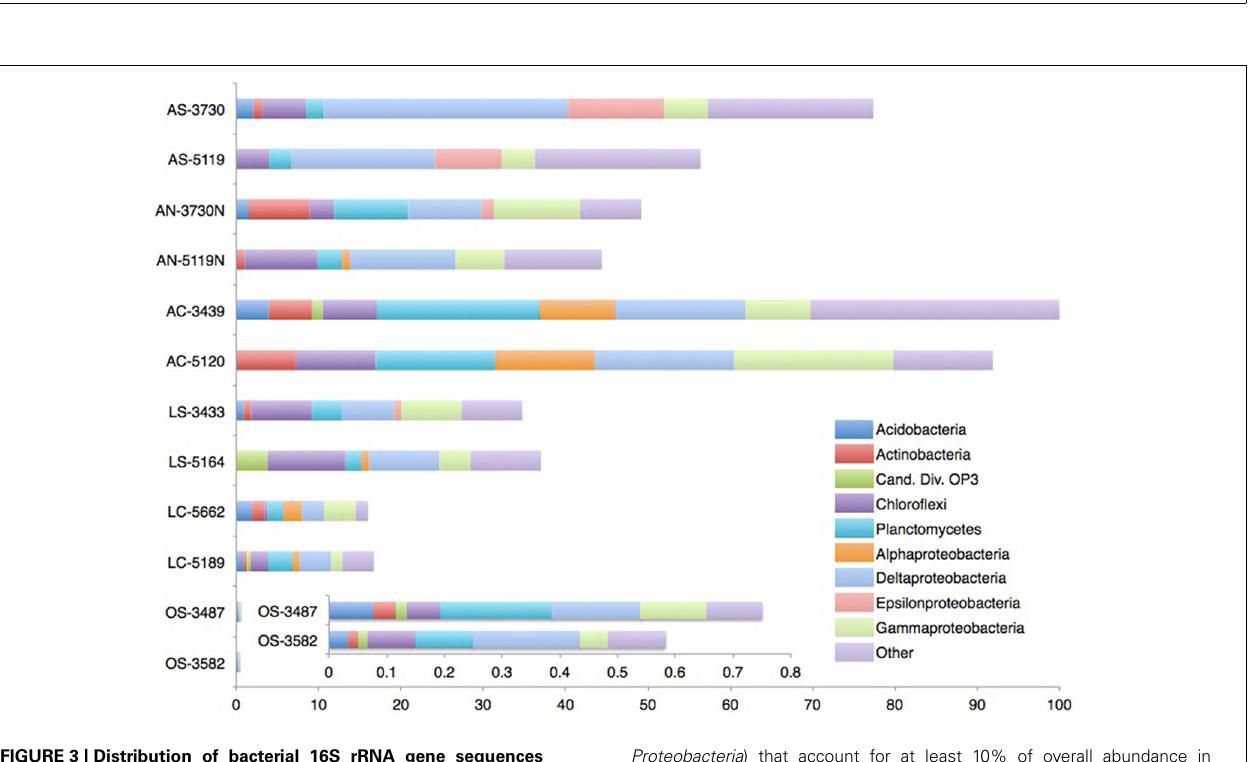
abundance, as the longest bar (see Table 2 ). Each bar segment length represents the microbial abundance-weighted proportion of that sample’s clones falling within the phylogenetic group in question. Inset: Off-seep samples OS-3487 and OS-3582 have biomass values orders of magnitude lower than those of seep-associated samples.